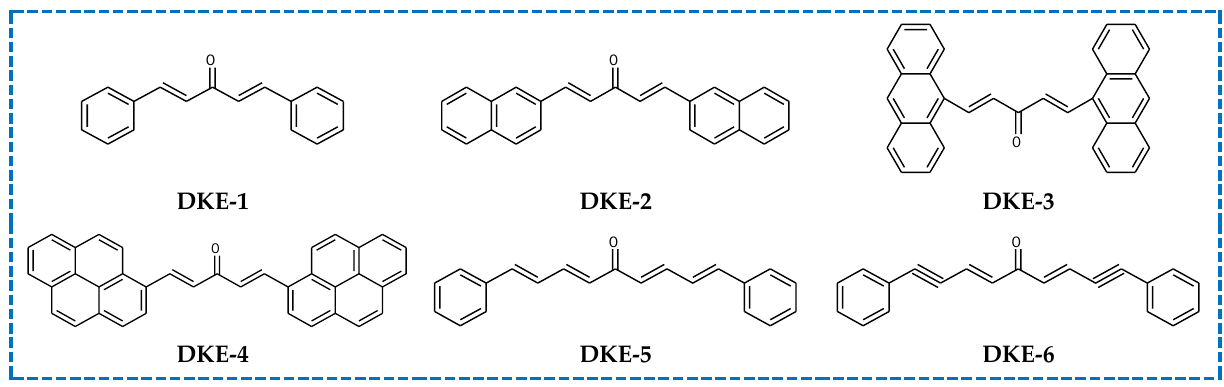
Figure 7. Chemical structures of bis -chalcone sensitizers proposed by Deng and Qu [73]. These compounds — proposed by Deng and Qu — are characterized by a wide range of absorption, from 300 nm to 500 nm, and quite high molar absorption coefficients, about 5 × 10 4 M −1 × cm −1 . The photopolymerization experiments were carried out for three-component systems consisting of an appropriate bis -chalcone sensitizer (DKE-1–DKE-6), diphenyliodonium hexafluorophosphate (Iod) and triethanoloamine (TEOA). The highest kinetics parameters of polymerization of poly(ethylene glycol) diacrylate (PEGDA) under 405 nm LED were obtained for compositions containing 0.1 wt% DKE, 2.0 wt% Iod and 2.0 wt% of TEOA. For these systems, the values of final monomer conversion ranged from 60% to ca. 90% for the most effective PI. Besides high conversion rates, newly synthesized initiators show good solubility in various monomers and a low migration ratio. Due to low toxicity, the proposed photoinitiating systems can be successfully used in the medical sector, e.g., as initiators of polymerization of light-cured dental compositions [74]. An interesting group of sensitizers of polymerization reactions are push – pull dyes.